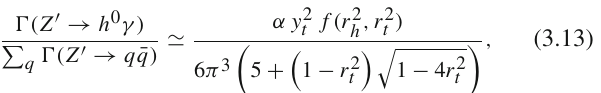
fraction is plotted as a function of M Z (cid:2) in the left panel of Fig. 3. A Z (cid:2) boson with flavor-universal couplings to all SM quarks arises in the presence of an extension of the SM gauge group by a U ( 1 ) B symmetry, with all quarks carrying the same charge (by convention z F = 1 / 3 while the gauge cou- pling g z is a free parameter). The cancellation of the gauge anomalies involving U ( 1 ) B requires new fermions (called anomalons), which must be chiral with respect to U ( 1 ) B , and are constrained to be vectorlike with respect to the SM gauge group. Specific sets of anomalons were introduced in Refs. [26–32]. The couplings of the anomalons to the Higgs doublet are model dependent. In the limit where these vanish, the anomalons do not contribute to the Z (cid:2) → h 0 γ width. The Z (cid:2) production cross section is proportional to g 2 have computed the inclusive leading-order production cross section of the Z (cid:2) , σ( pp → Z (cid:2) + X ) , at the 13 TeV LHC using MadGraph [13], with model files generated by